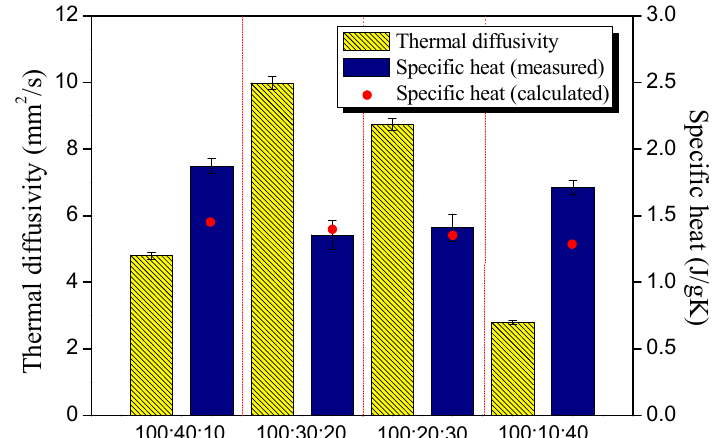
Figure 3. Thermal diffusivity and specific heat values of the composites with different mixing ratios of polypropylene:carbon fibers:graphite flake (Specific heat values of reference PP, CF, and GP are 1.8, 0.75, and 0.7 J/gK, respectively).